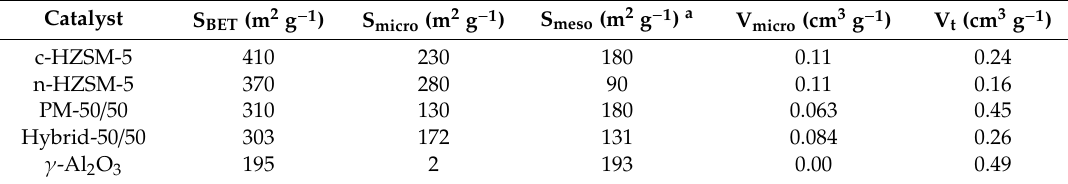
Table 2. Textural properties of the catalysts used in this work.